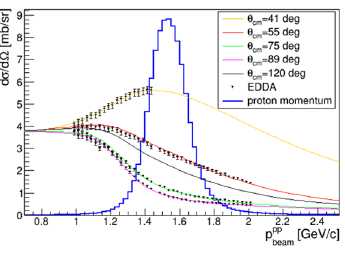
Figure 1. Di ff erential cross sections for proton-proton elastic scattering as a function of the e ff ective beam momentum for di ff erent values of the scattering angle in the CM frame. Triangles show EDDA collaboration data [21]. Lines denote SAID calculations [20]. Blue line presents distribution of the e ff ective beam momentum obtained from